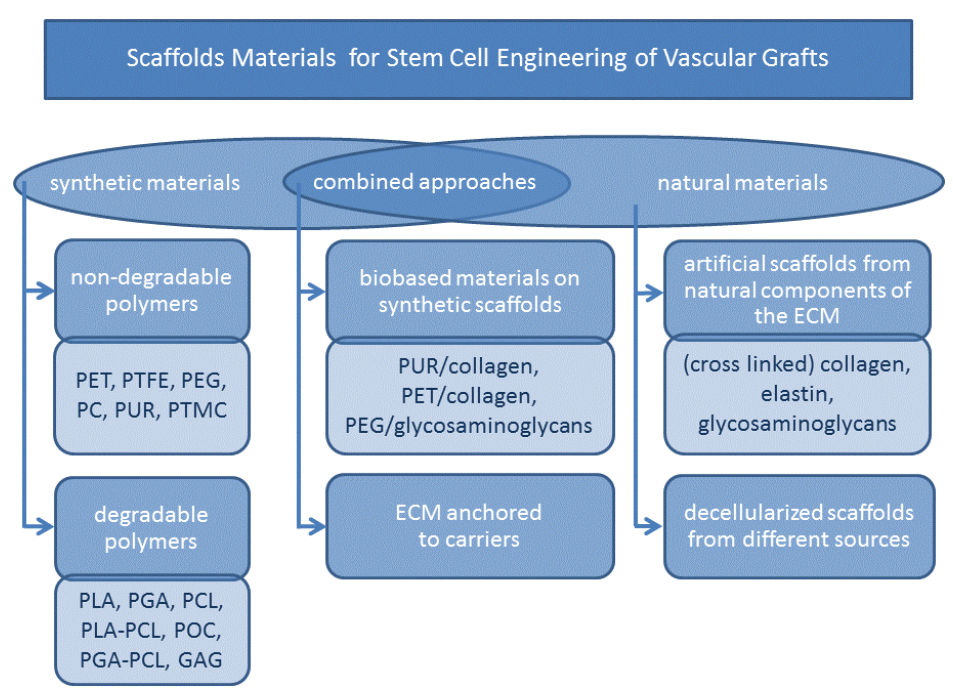
Figure 3. Scaffolds materials for stem cell engineering of vascular grafts. This scheme gives an overview about the materials discussed in this review with respect to the origin of the scaffold material. Synthetic and natural materials are addressed in the discussion as well as combined approaches to scaffold